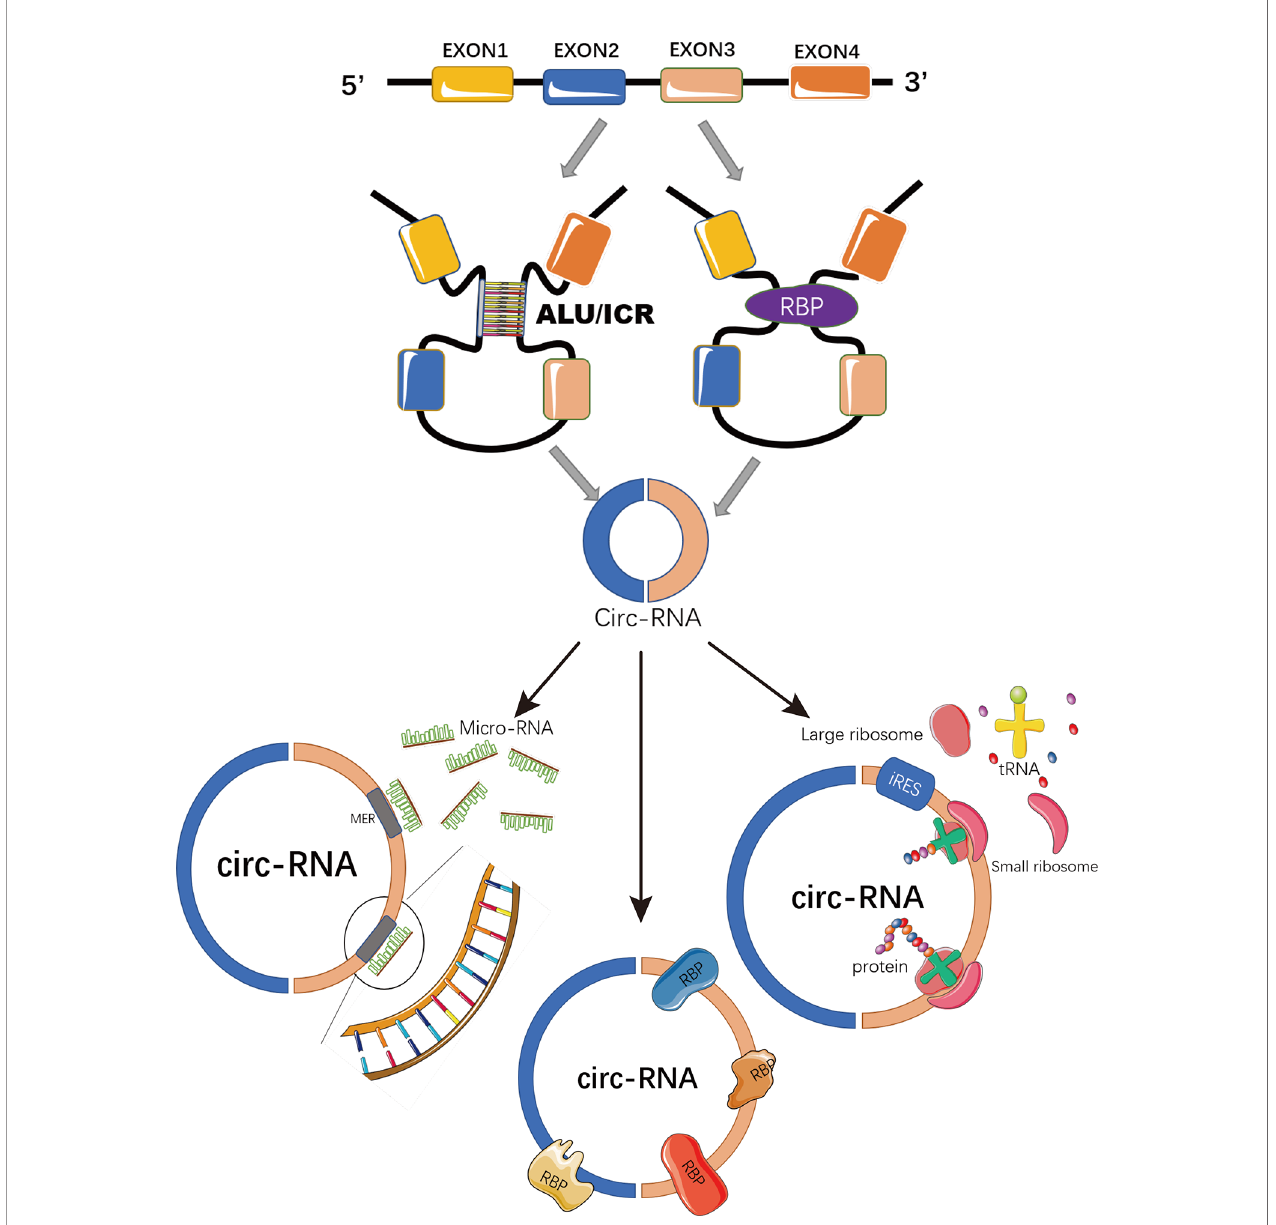
FIGURE 1 | Schematic representation of circRNA biogenesis and functions. CircRNAs are covalently closed loop structures generated by back-splicing of pre- mature transcripts mediated by either Alu repeats, inverted complementary repeats (ICR), or RNA binding proteins (RBP). CircRNAs could function as miRNA sponges to block miRNA-mediated inhibition on target genes; or as scaffolds, recruiters or decoys of some RNA binding proteins to regulate the function of the associated proteins. Some circRNAs containing IRES and ORFs serve as RNA template for